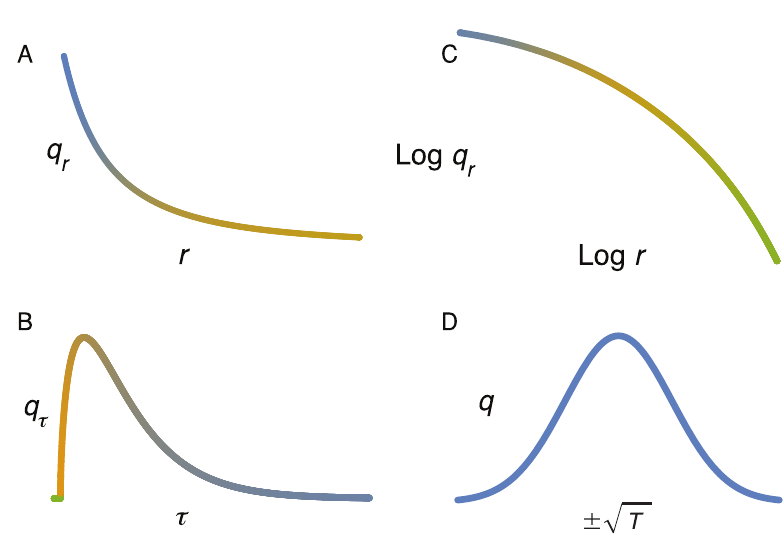
Figure 2. A pair of common natural metrics related by dimensional inversion, with generic expression by the normal distribution. ( A ) The probability distribution based on the natural metric in equation 1, with T = log(1 + ar ) + γ r . This plot uses a linear abscissa, compared r with the logarithmic abscissa of Figure 1A. The curve approximately fits the enzymatic rate data in Figure 2B of Iversen et al. 12 , in which r has units S/t measured as number of molecules per unit time (seconds). Here, r varies between 0 and 8. The approximately fitted parameters are a = 0.5, γ = 0.05, and λ = 1.6. ( B ) The Laplace transform of the upper panel yields a shifted gamma probability distribution that expresses the identical information with a natural metric T = (1/ λ − 1)log( τ − γλ ) + τ / λ a . The inverted measure τ has units t/S as time per molecule, varying τ in the plot between γλ and 4. ( C ) The same probability distribution as in panel A , on a double log scale over the range of r values 0.6 to 50. ( D ) Both the original distribution in A and the Laplace inverted distribution in B are normal distributions when expressed in relation to the square root of their respective natural metrics, with generalized variance σ ˜ 2 in equation